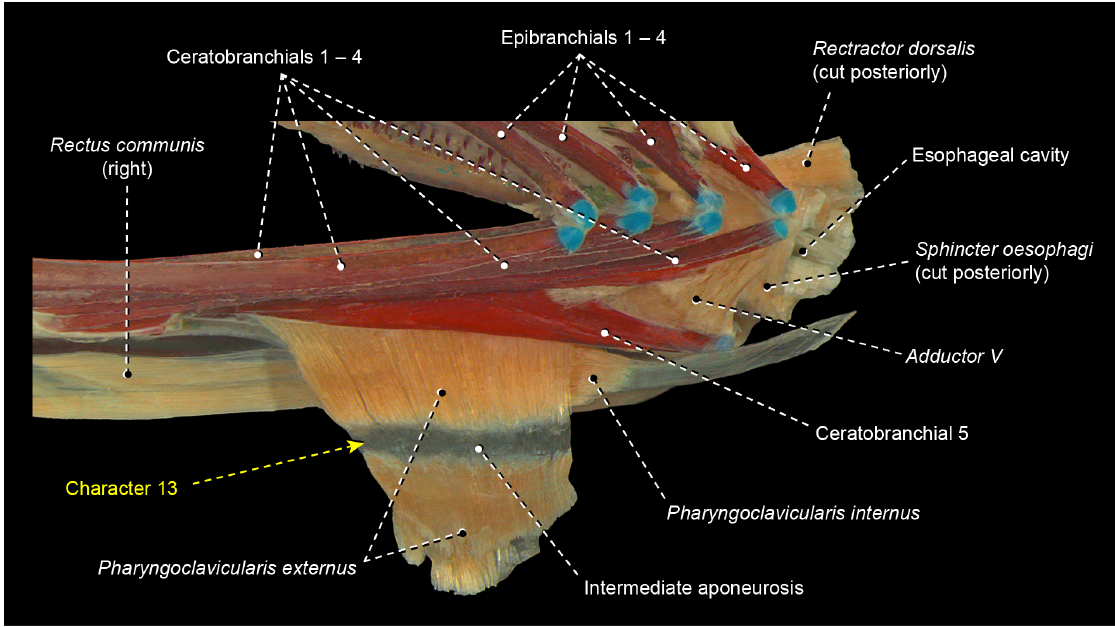
Figure 14. Ventroposterior region of branchial musculoskeletal system of Sphyraenaobtusata (Scombriformes: Sphyraenidae). MZUSP 37378. Left lateral view; gill rakers and left rectus communis removed.